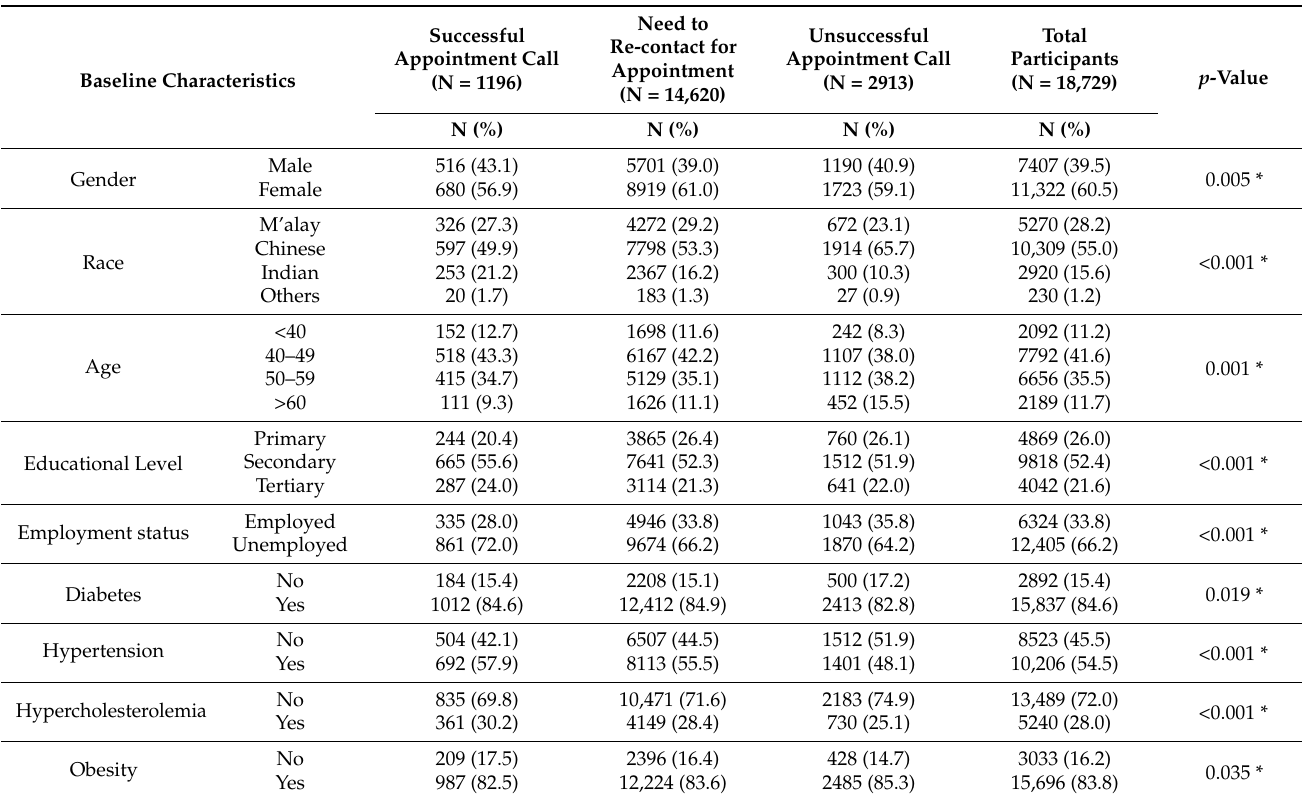
Table 2. Baseline characteristics of TMC participants residing in the Kuala Lumpur and Selangor area according to appointment call scheme 2019. (N =